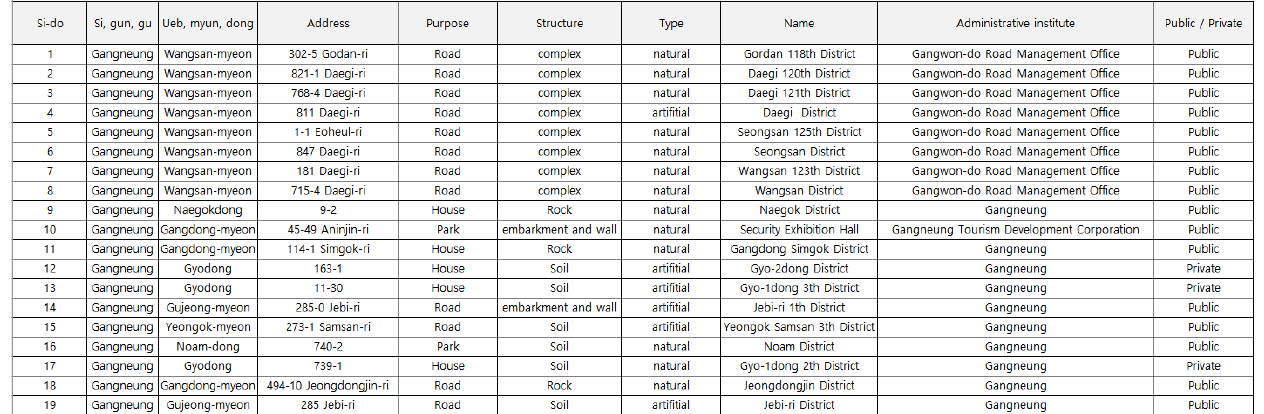
Figure 11. GGSJ data management format of the MOIS in 2020.